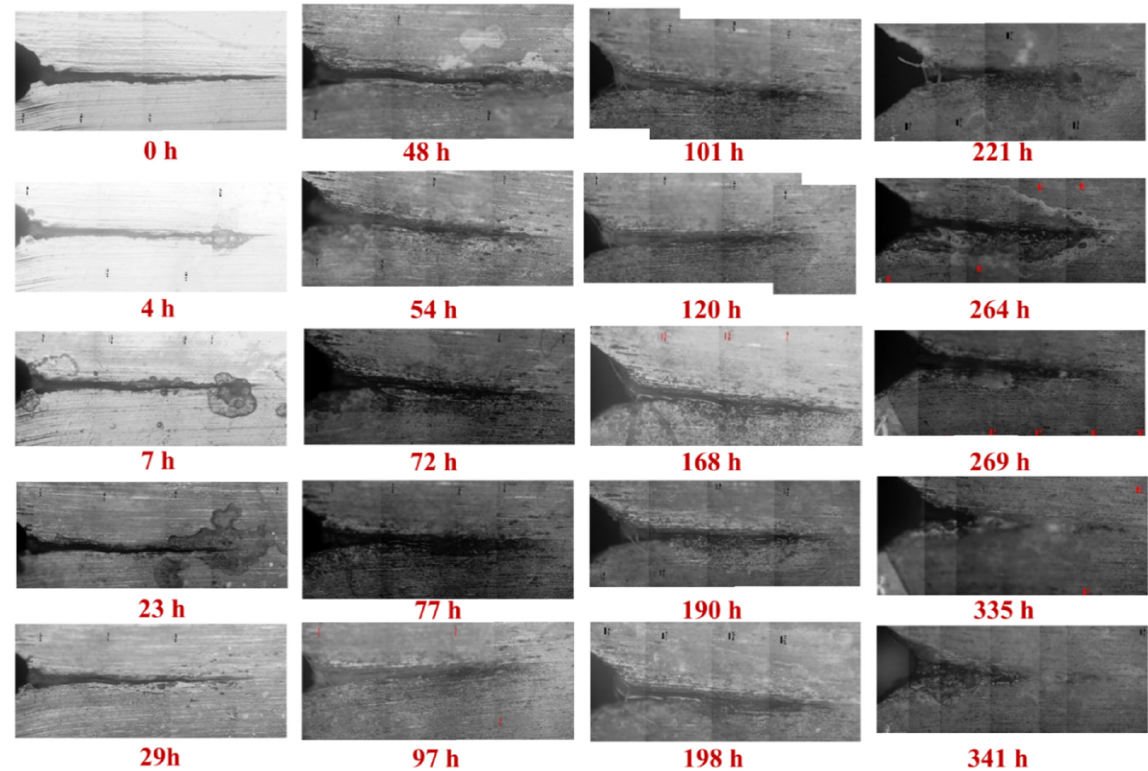
Figure 2. The crack propagations in the A ‐ plane of the pre ‐ cracked self ‐ stressed DCB specimen, characterized by OM.